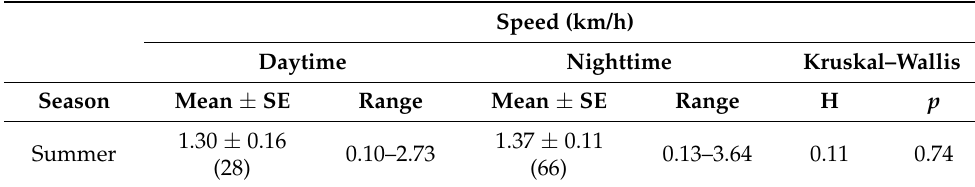
Table 4. Mean (mean ± SE) nocturnal (nighttime) and diurnal (daytime) speeds in summer. Kruskal– Wallis ANOVA tested differences.